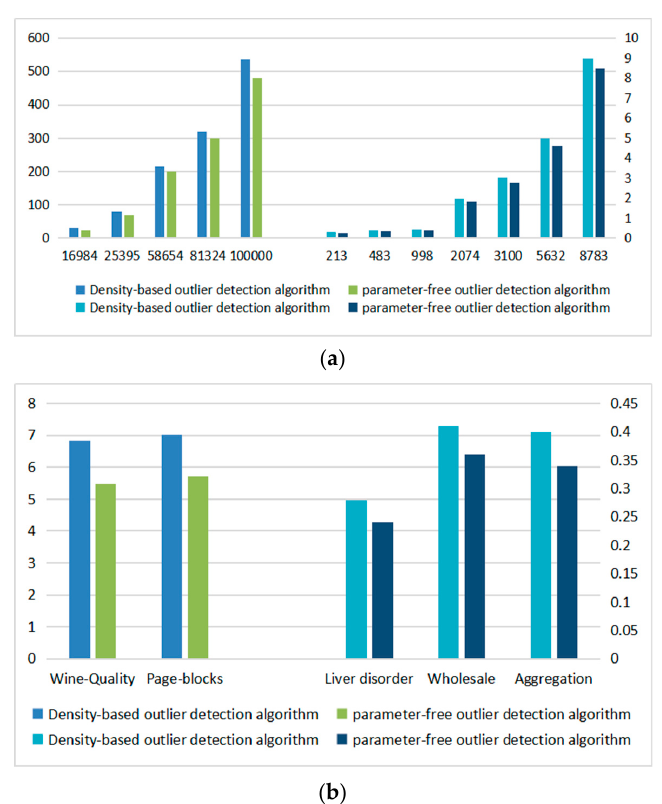
Figure 10. Comparisons of algorithm time consumption: ( a ) Comparisons of the time consumed by a parameter-free outlier detection algorithm and density-based outlier detection algorithm(s) (the size of datasets: |N| = 213–|N| = 100,000 ) ; ( b ) comparisons of the time consumed by a parameter-free outlier detection algorithm and density-based outlier detection algorithm(s) (real-world datasets).